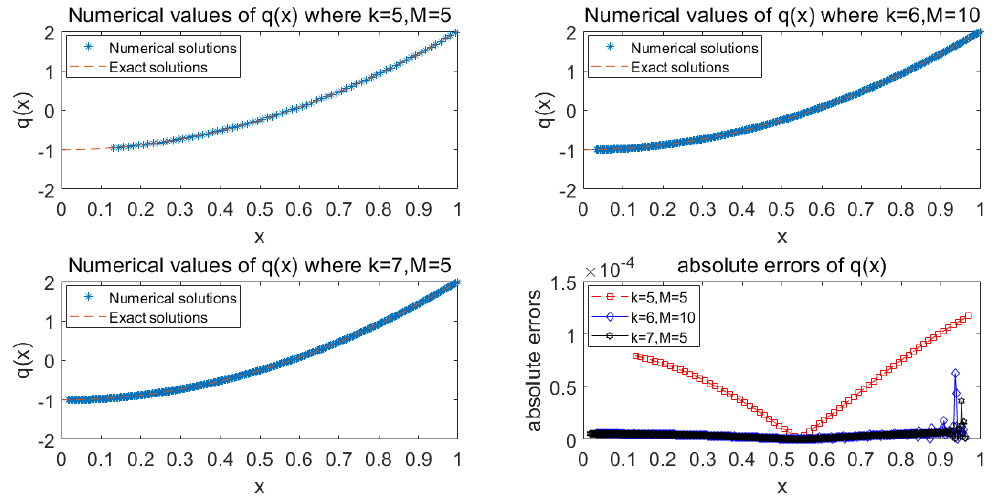
Figure 3. Numerical values of q ( x ) and absolute errors between the approximation and exact solutions of q ( x ) with k = 5,7, M = 5, and k = 6, M = 10 in Example